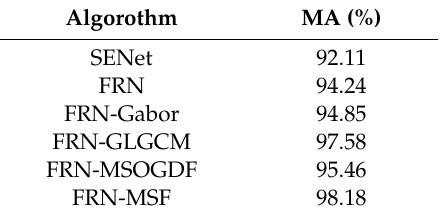
Table 5. Classification accuracy of different algorithms.